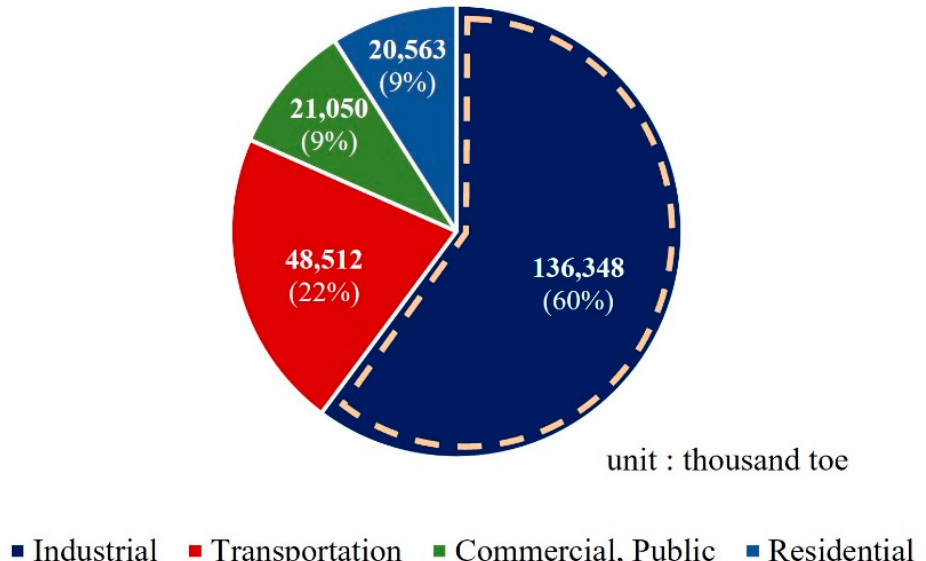
Figure 1. Energy consumption by sector in South Korea in 2019.